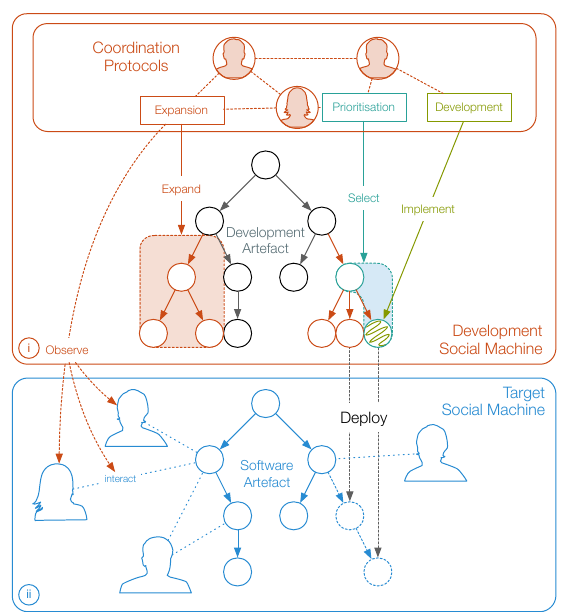
Figure 2. Interaction between the development and target social machines, including development steps, developer interaction, user observation and community interaction.